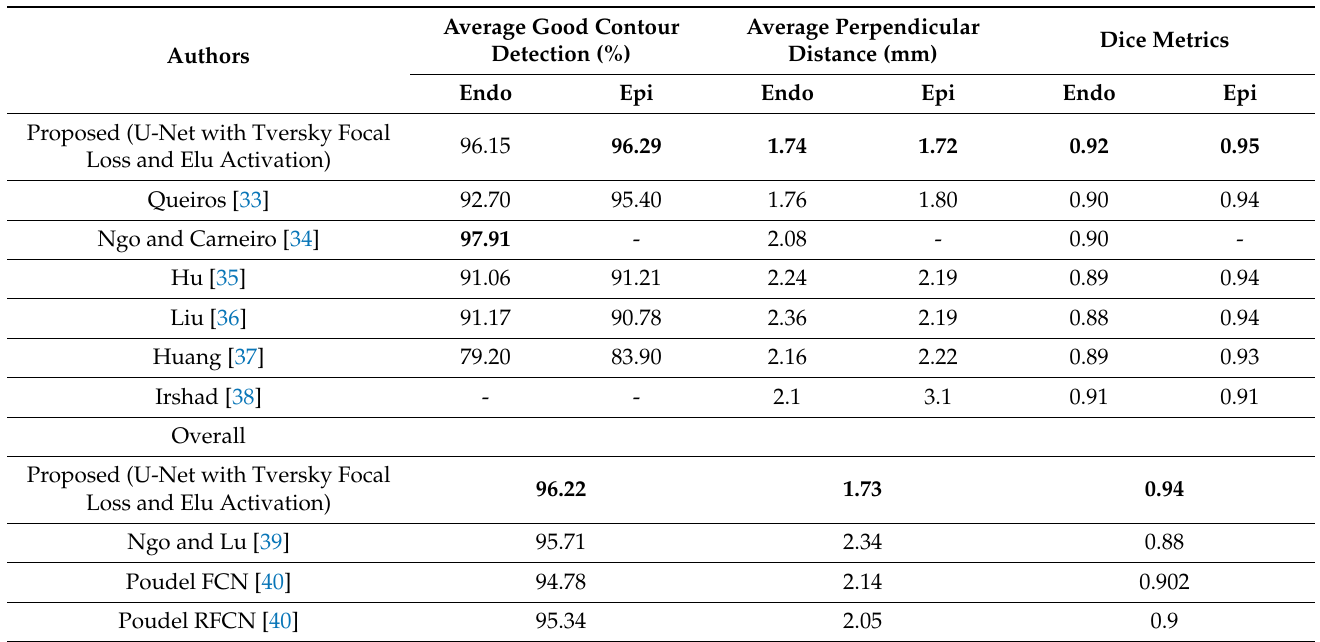
Table 18. Comparison of LV endocardium and epicardium segmentation performance between our proposed approach and previous research using the same